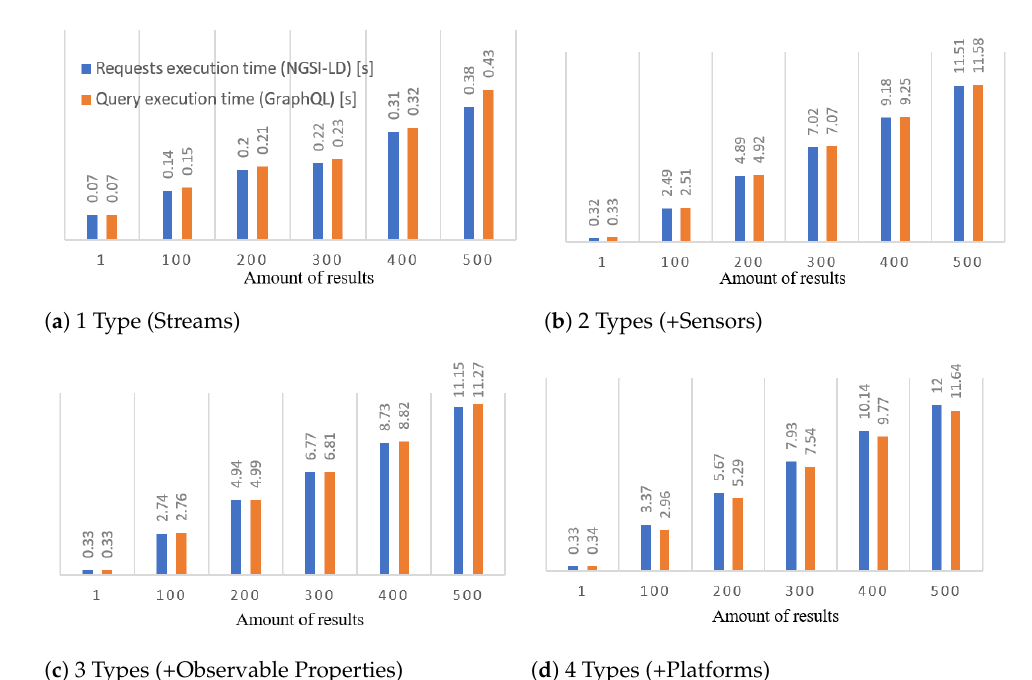
Figure 18. Requests execution time (Next Generation Service Interface for Linked Data (NGSI-LD)) vs. query execution time